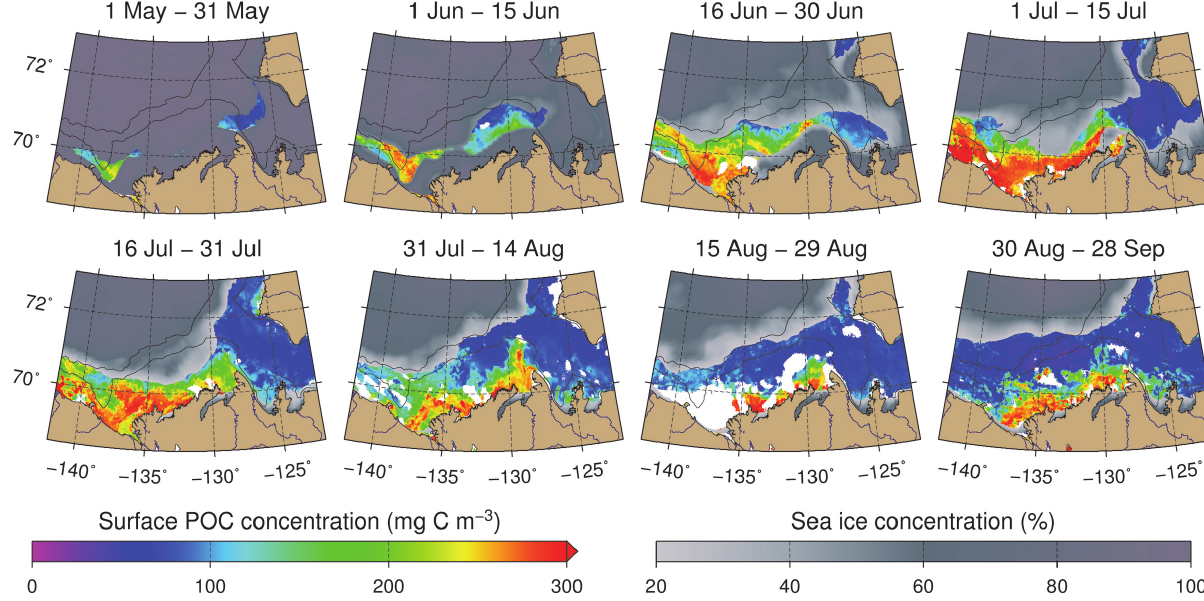
Fig. 3. MERIS composites of surface POC concentrations from May to September 2009 in the southeast Beaufort Sea as estimated with an empirical relationship established between in situ POC and the blue-to-green ratio of remote-sensing reflectance (490, 560nm) measured during the CASES 2004 and Malina 2009 field campaigns. Sea ice concentration data (grayish scale, from 20% to 100% ice cover) as obtained from the SSM/I-DMSP orbiting sensor were superimposed over the satellite composites of surface POC concentrations (1km resolution, 5km radius interpolation). White patches correspond to ice-free areas within which no MERIS data were available during the time period due to the presence of clouds. The two bathymetric contour lines in each figure correspond to the 100 and 1000m